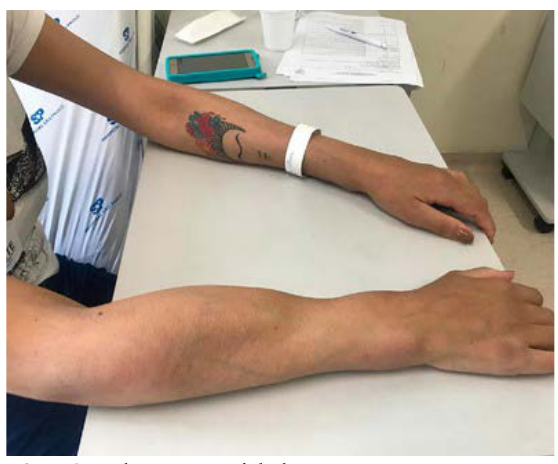
fIguRE 1 – Bulging in super right